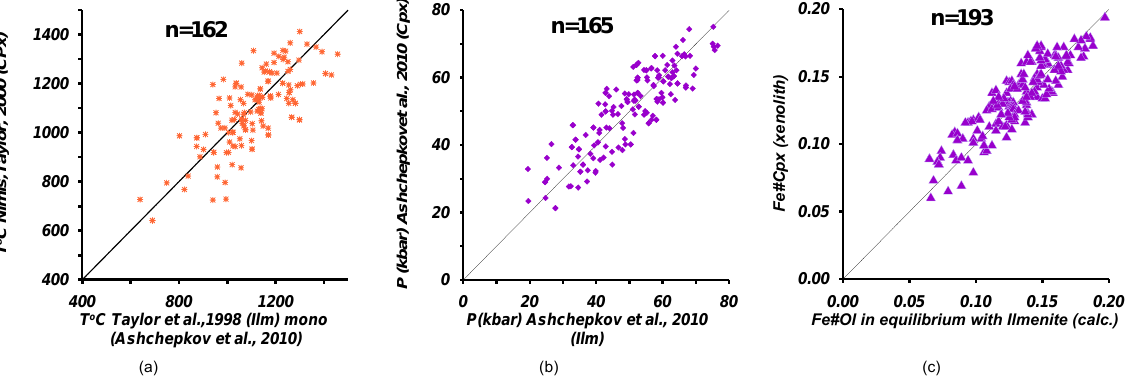
Figure 7. Correlations of pressure (a) , temperature (b) and calculated Fe#Ol for ilmenites and clinopyroxenes (Ashchepkov, 2010) from the same associations.